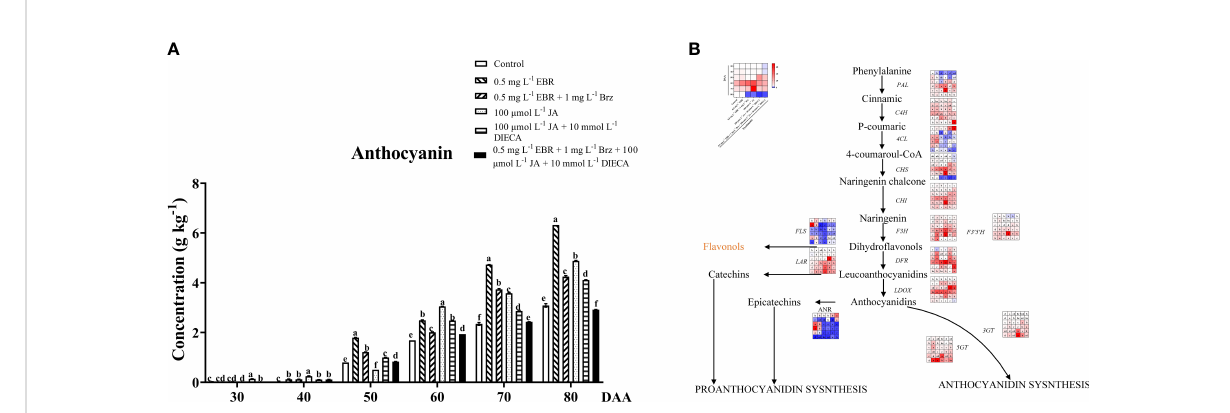
FIGURE 2 Effect of exogenous EBR, JA and their signaling inhibitors on anthocyanins accumulation. (A) Effect of exogenous EBR, JA and their signaling inhibitors on anthocyanins contents in different treatment groups (Control, 0.5 mg L -1 EBR, 100 m mol L -1 JA, 0.5 mg L -1 EBR + 1 mg L -1 Brz, 100 m mol L -1 JA + 10 mmol L -1 DIECA, 0.5 mg L -1 EBR + 1 mg L -1 Brz + 100 m mol L -1 JA + 10 mmol L -1 DIECA) at six sampling stages (DAA 30, 40, 50, 60, 70, 80). The levels of anthocyanins were expressed in the form of a histogram. Error bars = ± SE (n ≥ 3). Signi fi cant differences among samples have been displayed by a – f letters (one-way ANOVA, P<0.05). (B) Expression of genes involved in anthocyanins biosynthesis and metabolic pathways in different treatment groups (Control, 0.5 mg L -1 EBR, 100 m mol L -1 JA, 0.5 mg L -1 EBR + 1 mg L -1 Brz, 100 m mol L -1 JA + 10 mmol L -1 DIECA, 0.5 mg L -1 EBR + 1 mg L -1 Brz + 100 m mol L -1 JA + 10 mmol L -1 DIECA) at six sampling stages (DAA 30, 40, 50, 60, 70, 80). The expression levels of genes were remarked as a heatmap. Signi fi cant differences among samples have been displayed by a – f letters (one- way ANOVA,